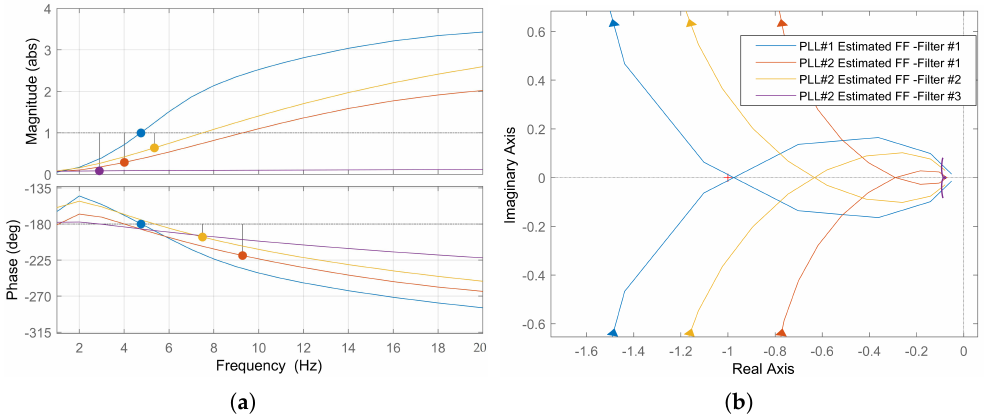
Figure 27. System eigenvalue λ 1 . Influence of contact-line voltage filter. ( a ) Bode diagram, ( b ) Nyquist diagram.